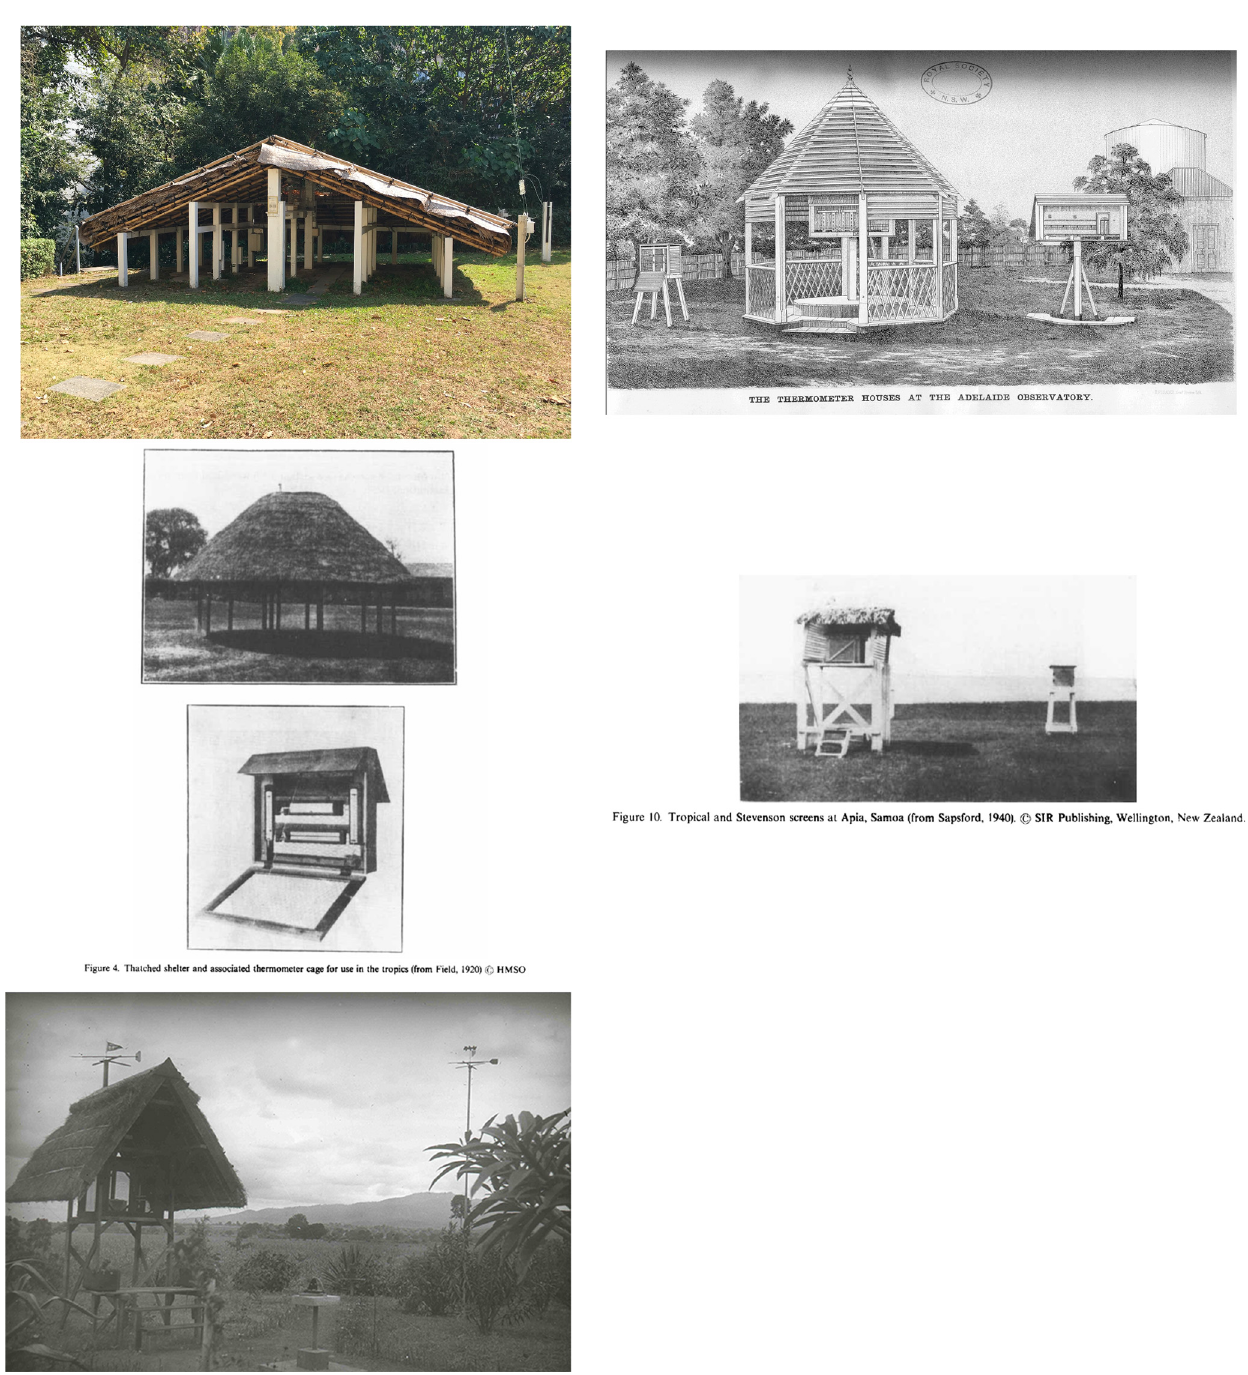
Figure 1. Summary of a number of known early tropical–subtropical observational practices. The top left is a picture of the old exposure used at the Hong Kong observatory, which is no longer operational but still maintained (courtesy Philip Brohan). The top right shows three set-ups (a Stevenson screen, a thermometer shed, and a Glashier stand) at the Adelaide observatory which undertook 60 years of parallel measurements (Royal Society of New South Wales and discussed further in Ashcroft et al., 2021). The centre left (thatched shelter) and right (tropical thatched screen) are taken from Parker (1994) (Figs. 4 and 10, respectively) and are the only two tropical locations with photographic evidence of instrumental set-up shown therein. The bottom left image is of the meteorological observation station at Kizunguzi, Tanzania (source: DWD, Archive of the Deutsche